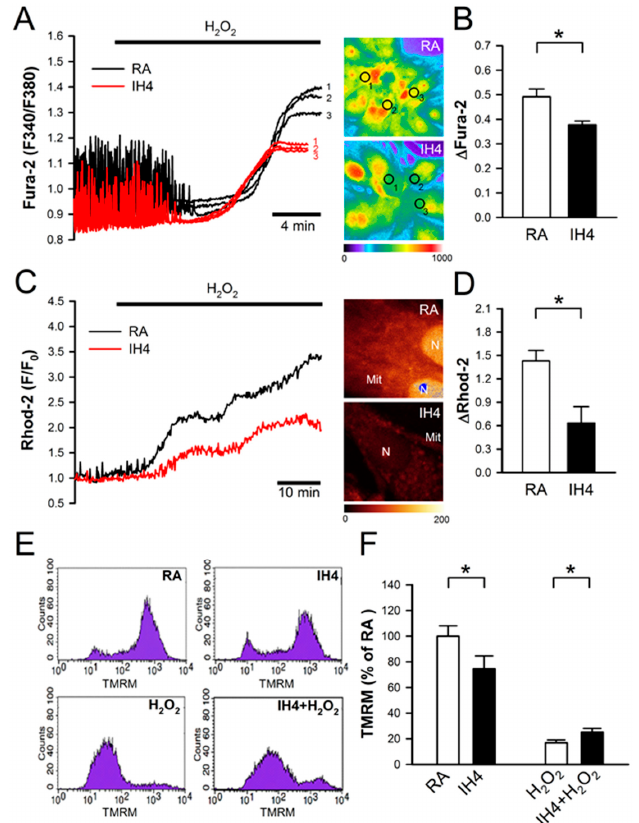
Figure 3. E ff ects of IH on H 2 O 2 -induced intracellular Ca 2 + increase and mitochondrial membrane Figure 3. Effects of IH on H 2 O 2 -induced intracellular Ca 2+ increase and mitochondrial membrane depolarization. ( A ) The left panel shows the time course of cytosolic Ca 2 + changes in depolarization. ( A ) The left panel shows the time course of cytosolic Ca 2+ changes in cardiomyocytes perfused with H 2 O 2 (30 μ M), and recorded by a real-time fluorescence imaging system. Treatment of cardiomyocytes to IH for four days attenuated H 2 O 2 -induced increases of the cytosolic Ca 2+ level. The